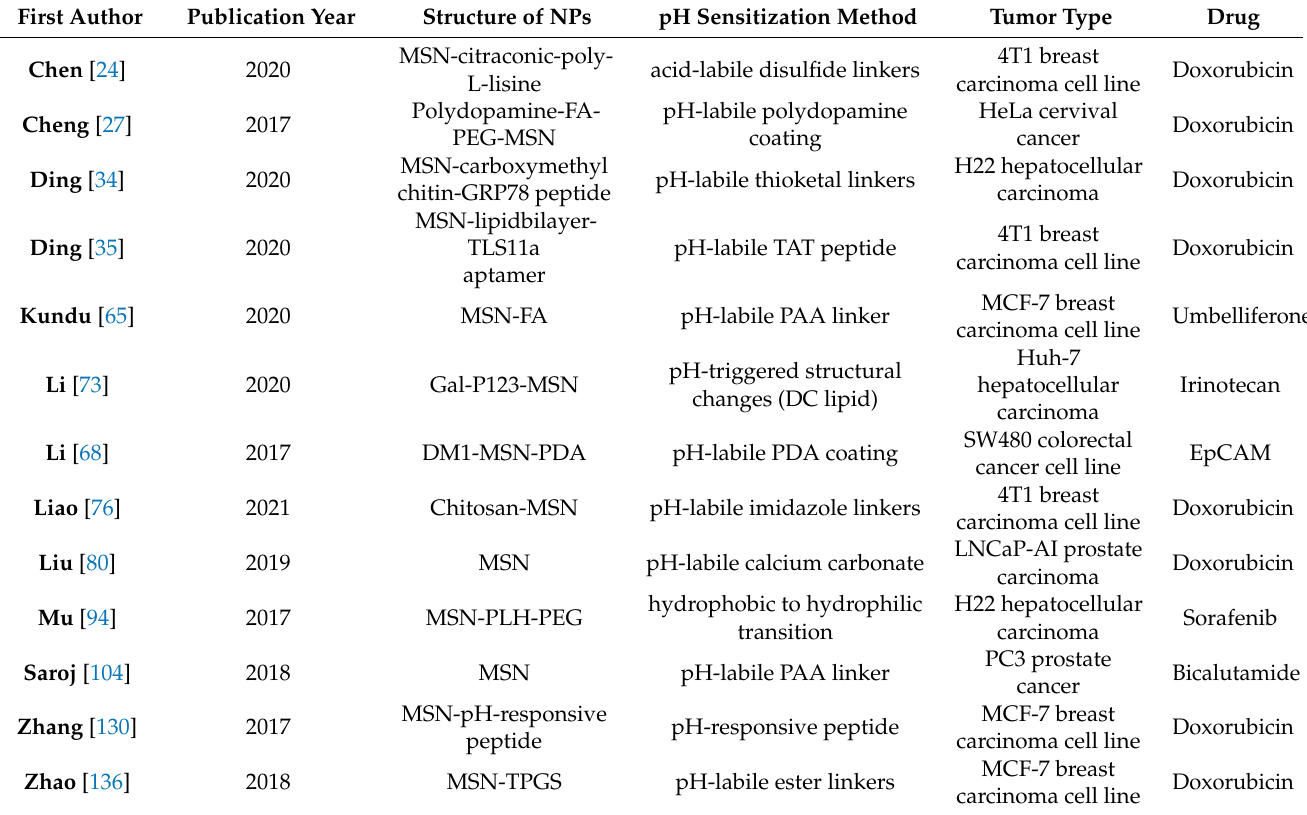
Table 4. Overview of mesoporous silica NPs: structure, pH sensitization method, tumor type, and delivered drug.